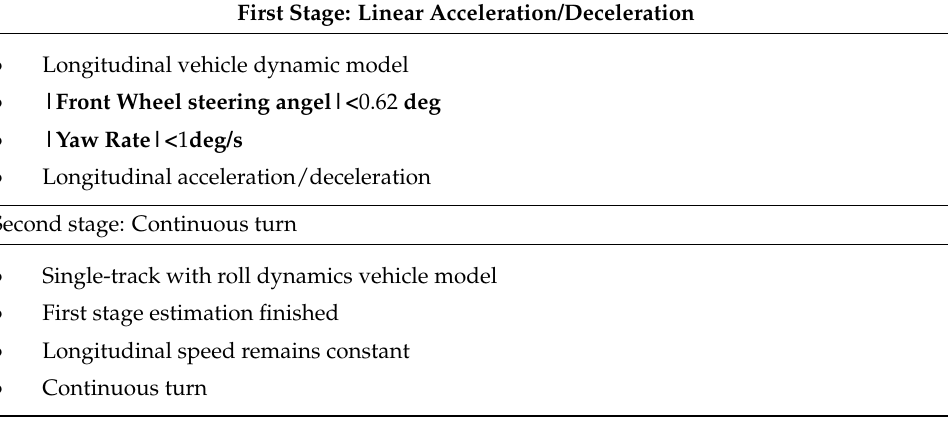
Table 2. Two-stage estimation condition requirements. First Stage: Linear